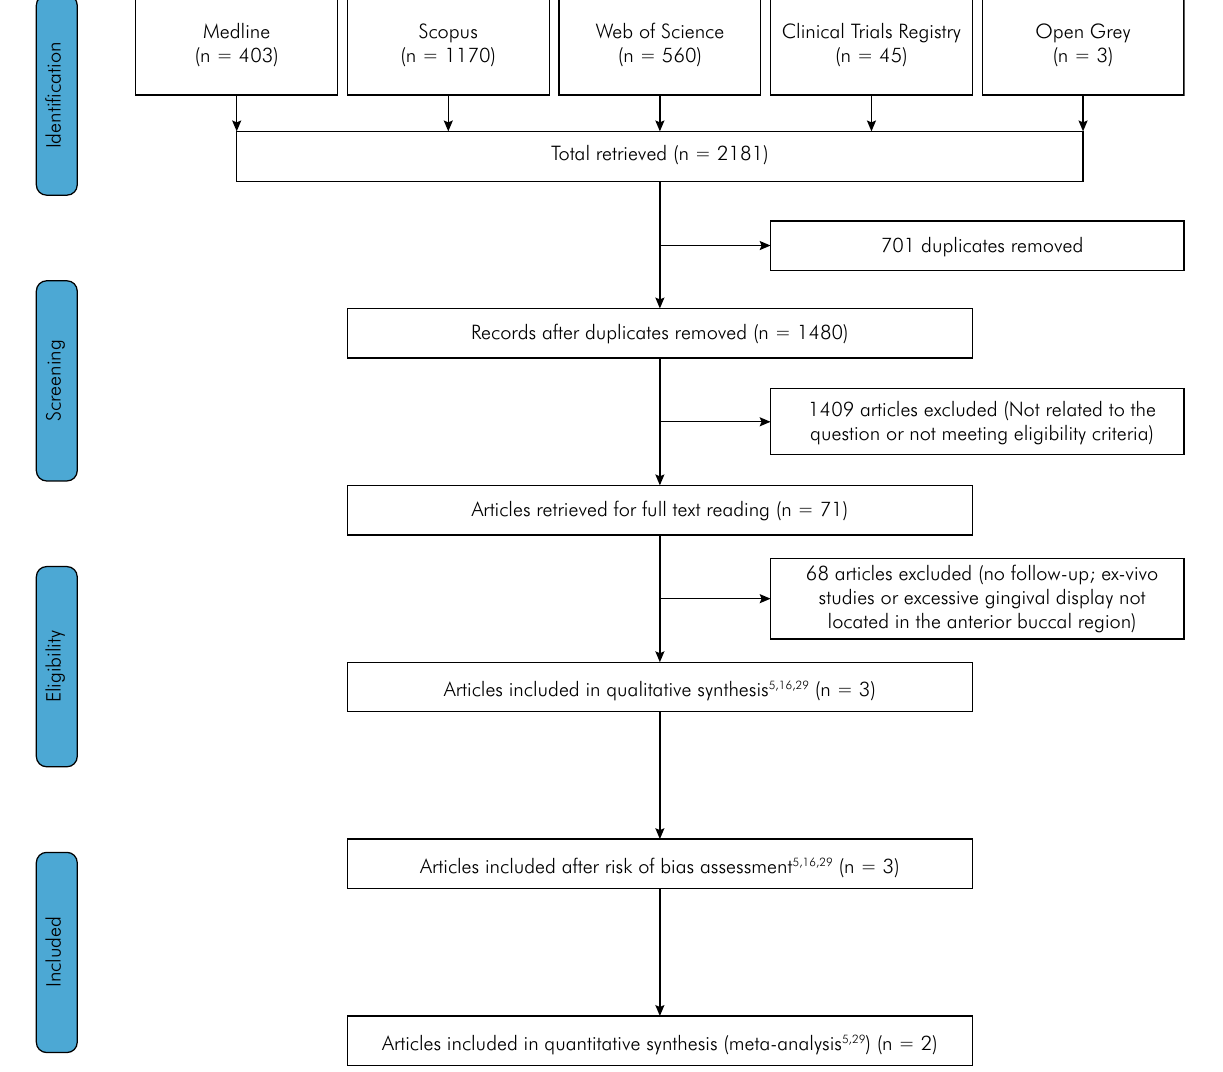
Figure 1. Flow diagram of the study selection process